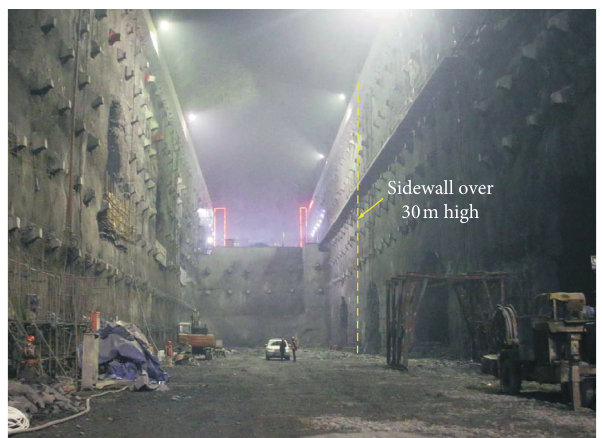
Figure 5: High sidewall at the underground powerhouse.